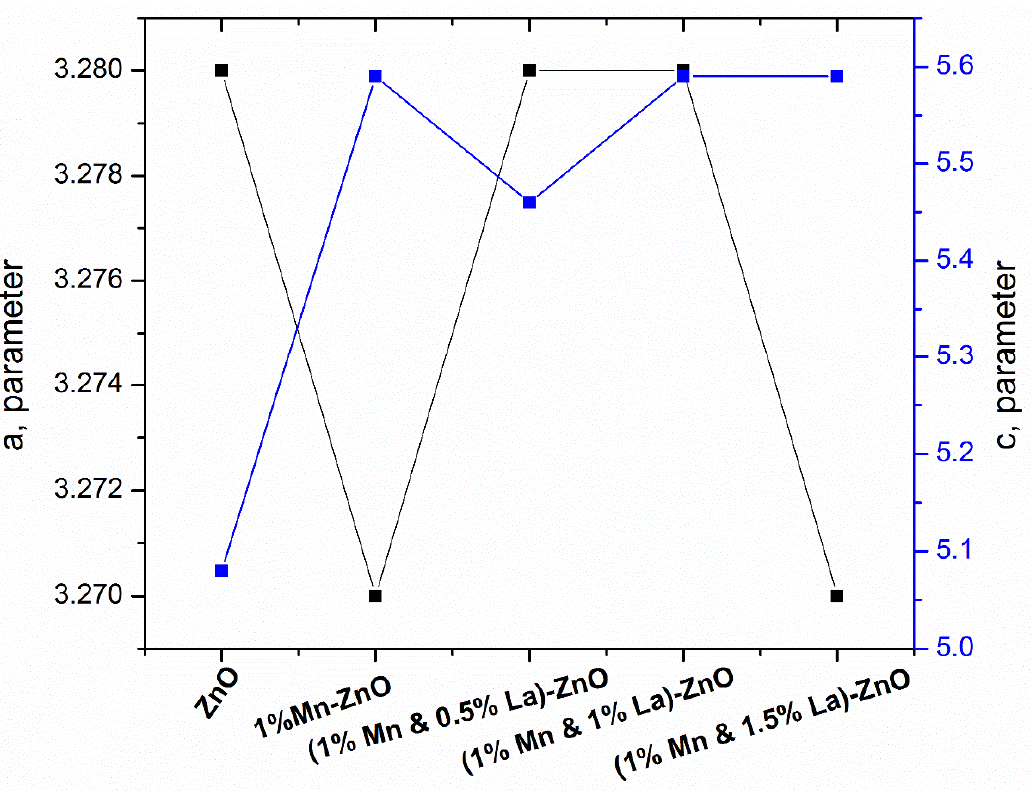
Figure 4. Graph lattice parameters versus pure and doped ZnO film.